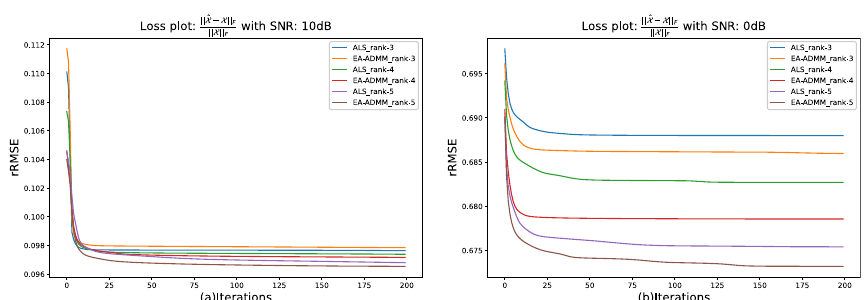
Fig. 8 Tensor recovery performance with various SNRs